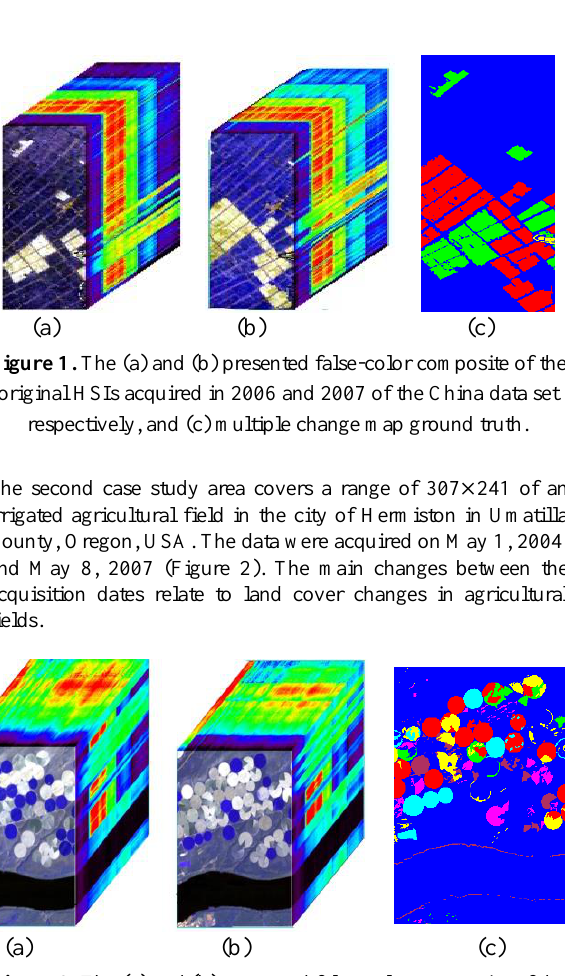
Figure 2. The (a) and (b) presented false-color composite of the original HSIs acquired in 2004 and 2007 of the USA data set respectively, and (c) multiple change map ground truth.